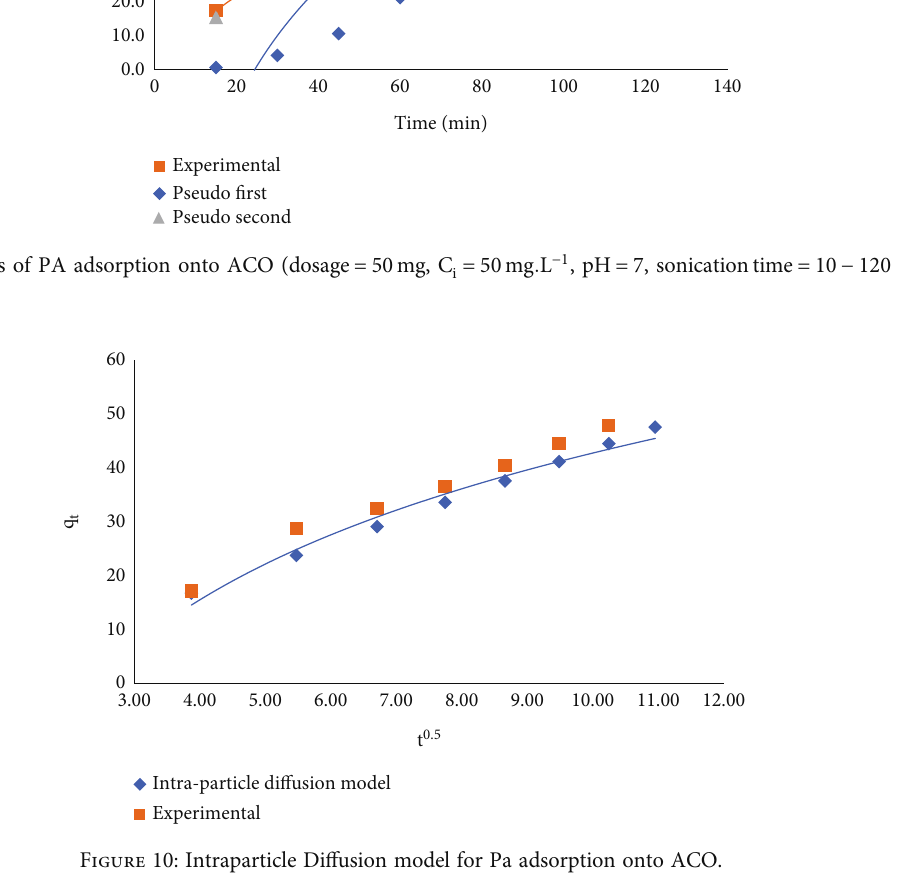
Figure 10: Intraparticle Di ff usion model for Pa adsorption onto